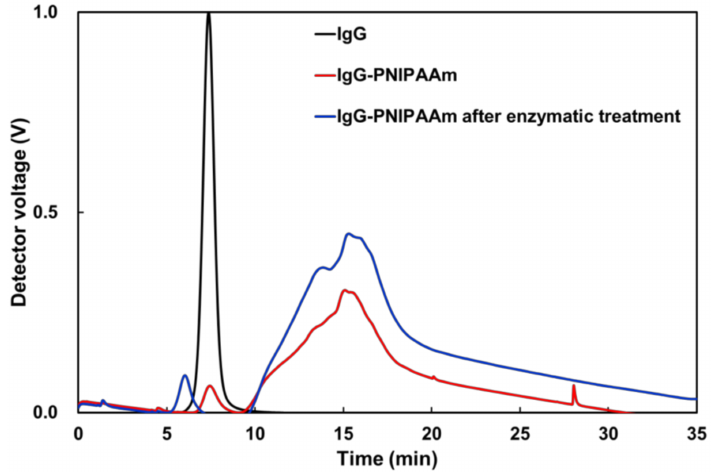
Figure 8. Separation profile of IgG and IgG–PNIPAAm conjugates before and after enzymatic treatment by